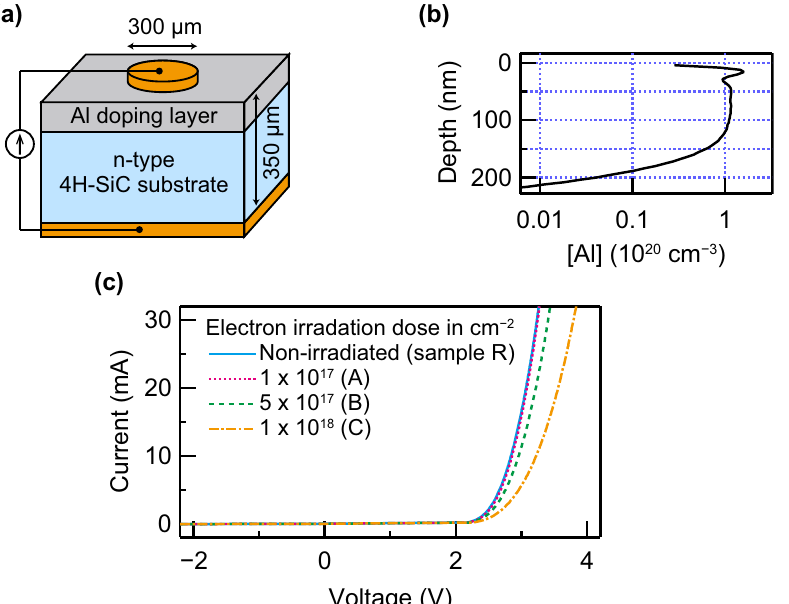
Figure 1. p–n junction diode in a bulk 4H-SiC substrate. ( a ) Schematic of a fabricated p–n junction structure. The nitrogen concentration in the n-type SiC substrate is on the order of 10 via the multistep implantation of Al ions. ( b ) Depth profile of the Al concentration, [Al]. In the flat-profile region, [Al] exceeds the nitrogen concentration. ( c ) Current–voltage characteristics of the samples with an electron irradiation dose of 0 (sample R), 1 × 10 electrical resistance is observed for the high-irradiation-dose